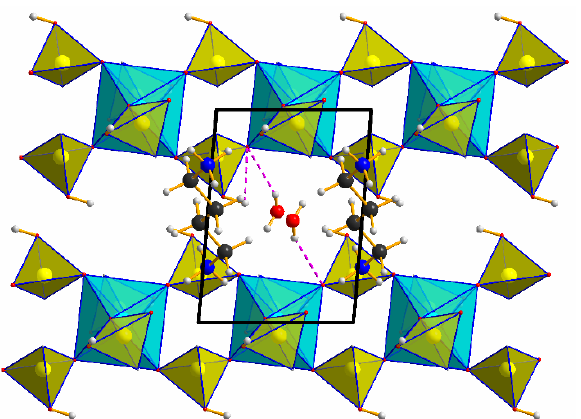
Figure 3. The crystal structure of (H 2 DAB)[Co(H 2 PO 3 ) 4 ] · 2H 2 O in a projection along c-axis emphasiz- ing the hydrogen bonds (dashed lines). Table2. Hydrogen bonding network in the framework of (H 2 DAB)[Co(H 2 PO 3 ) 4 ]·2H 2 O.